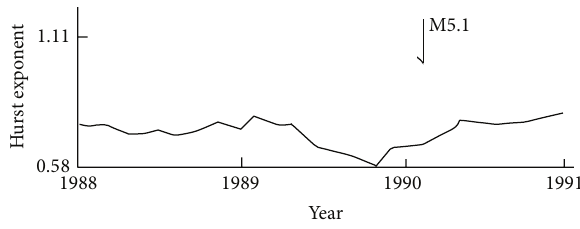
Figure 5: The temporal variation of Hurst exponent before and after the 22 April 1974 Liyang earthquake (M5.5).